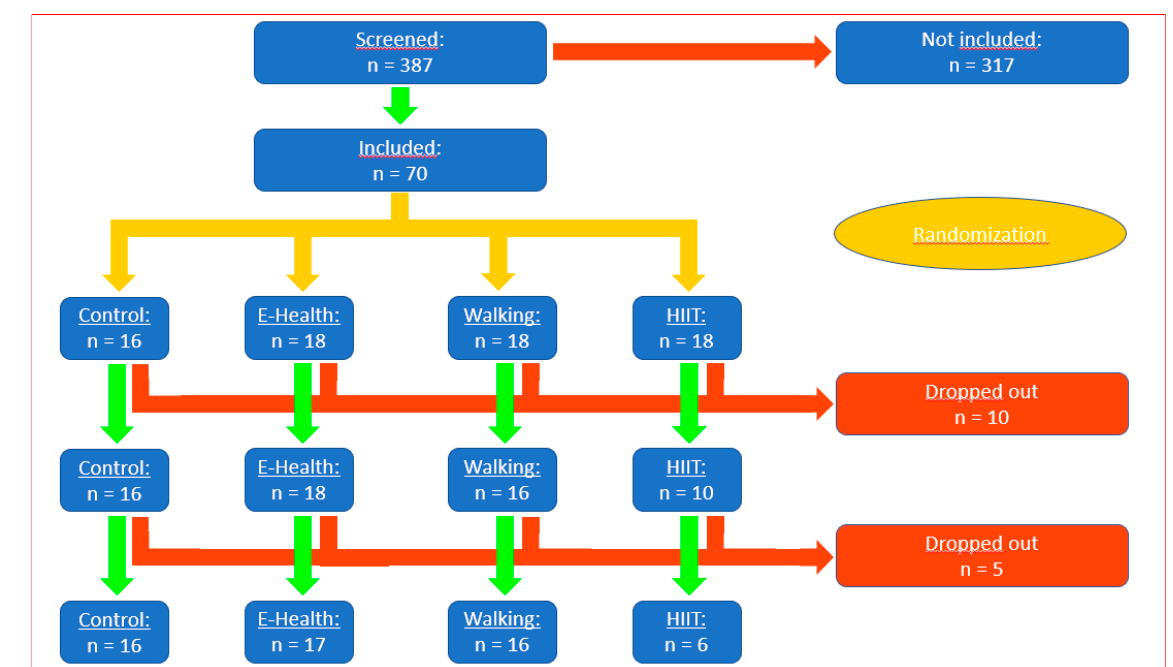
Figure 1. Flow diagram showing patients numbers at each stage of the